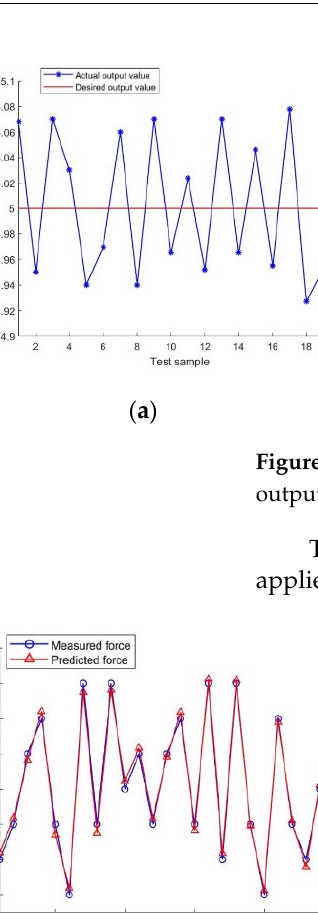
Figure 10. Output values of each channel when 5N load is applied in Fx direction. ( a ) Fx channel output value; ( b ) Fy channel output value; ( c ) Fz channel output value.